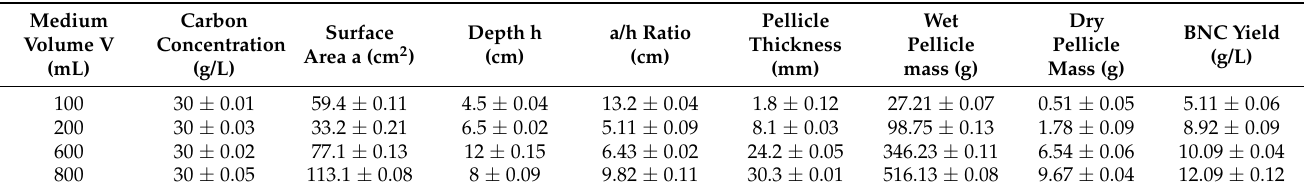
Table 4. Influence of surface area and culture medium depth ratio on the BNC yield after 14 days of cultivation in HS-Glc